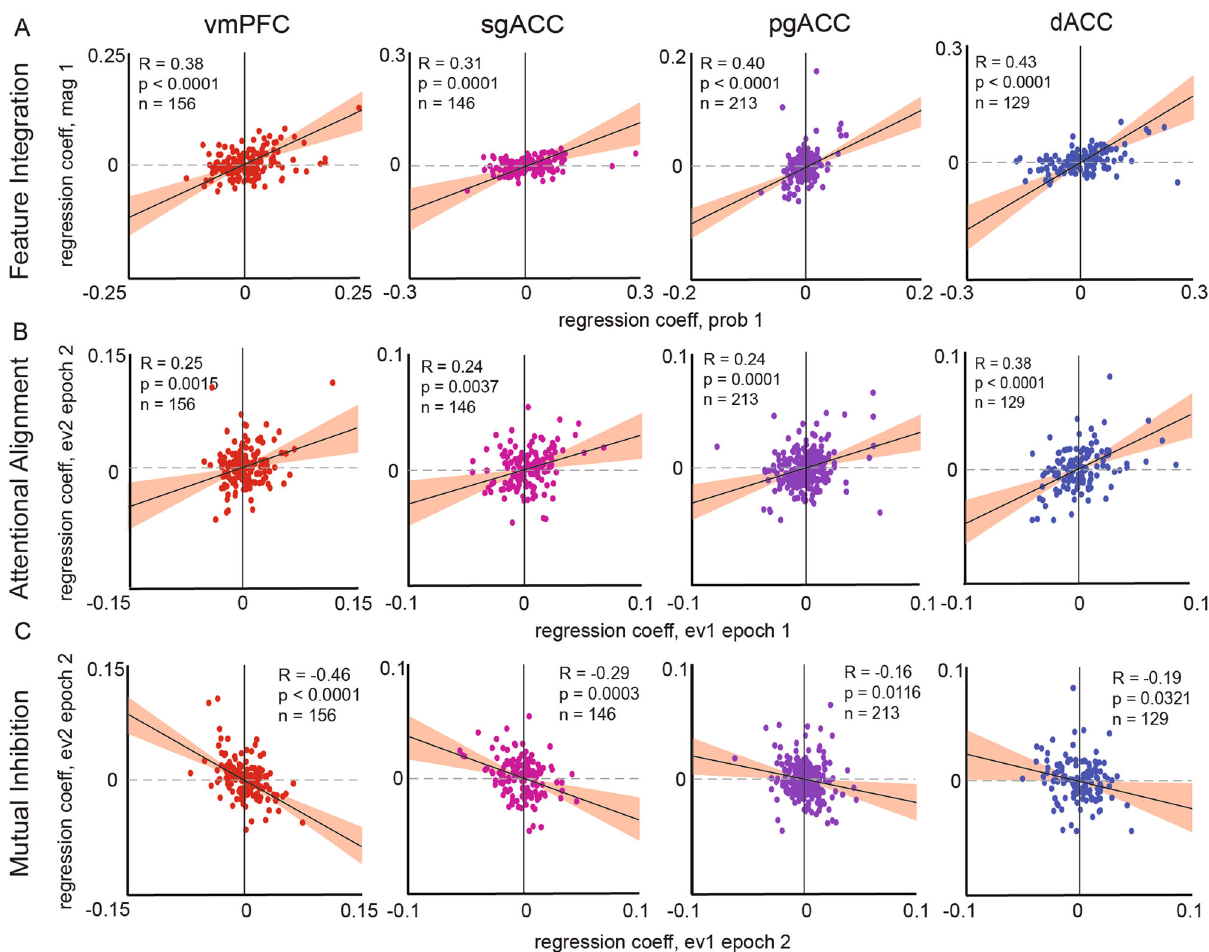
Fig. 4 Economic choice functions. A Feature integration. From left to right: Scatter plots of regression coef fi cients from regressing normalized epoch 1 fi ring rates on the probability of offering 1, against the regression coef fi cients from the magnitude of offer 1 (red = vmPFC, pink = sgACC, purple = pgACC, blue = dACC). The diagonal black line indicates the slope of the correlation between regression coef fi cients (Pearson ’ s correlation, with p -value computed as a two-sided test). The red ribbons indicate the 95% con fi dence intervals. Source data are provided as a Source Data fi le. B Attentional alignment. Scatter plots are of coef fi cients from regressing normalized epoch 1 fi ring rates on the expected value of offer 1, against the regression coef fi cients from epoch 2 fi ring rates on the expected value of the offer. The diagonal black line indicates the slope of the correlation between regression coef fi cients (Pearson ’ s correlation, with p -value computed as a two-sided test). The red ribbons indicate the 95% con fi dence intervals. Source data are provided as a Source Data fi le. C Mutual inhibition. Scatter plots are of coef fi cients from regressing normalized epoch 2 fi ring rates on the expected value of offer 1, against the regression coef fi cients from epoch 2 fi ring rates on the expected value of offer 2. The diagonal black line indicates the slope of the correlation between regression coef fi cients (Pearson ’ s correlation, with p -value computed as a two-sided test). The red ribbons indicate the 95% con fi dence intervals. Source data are provided as a Source Data fi